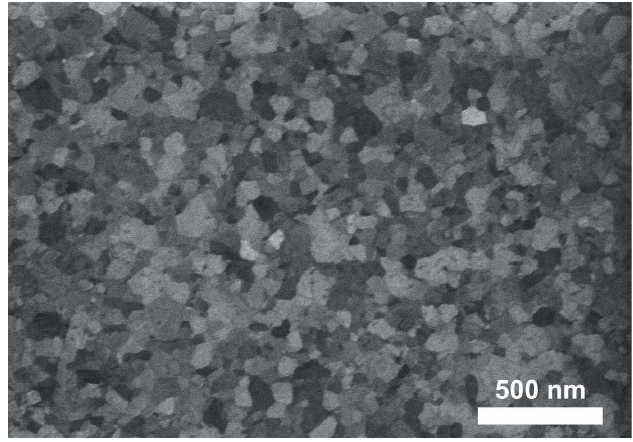
Figure 3 An SEM image of the Pt thin-film surface showing a polydisperse size distribution and different shapes of the Pt grains in the lateral direction.